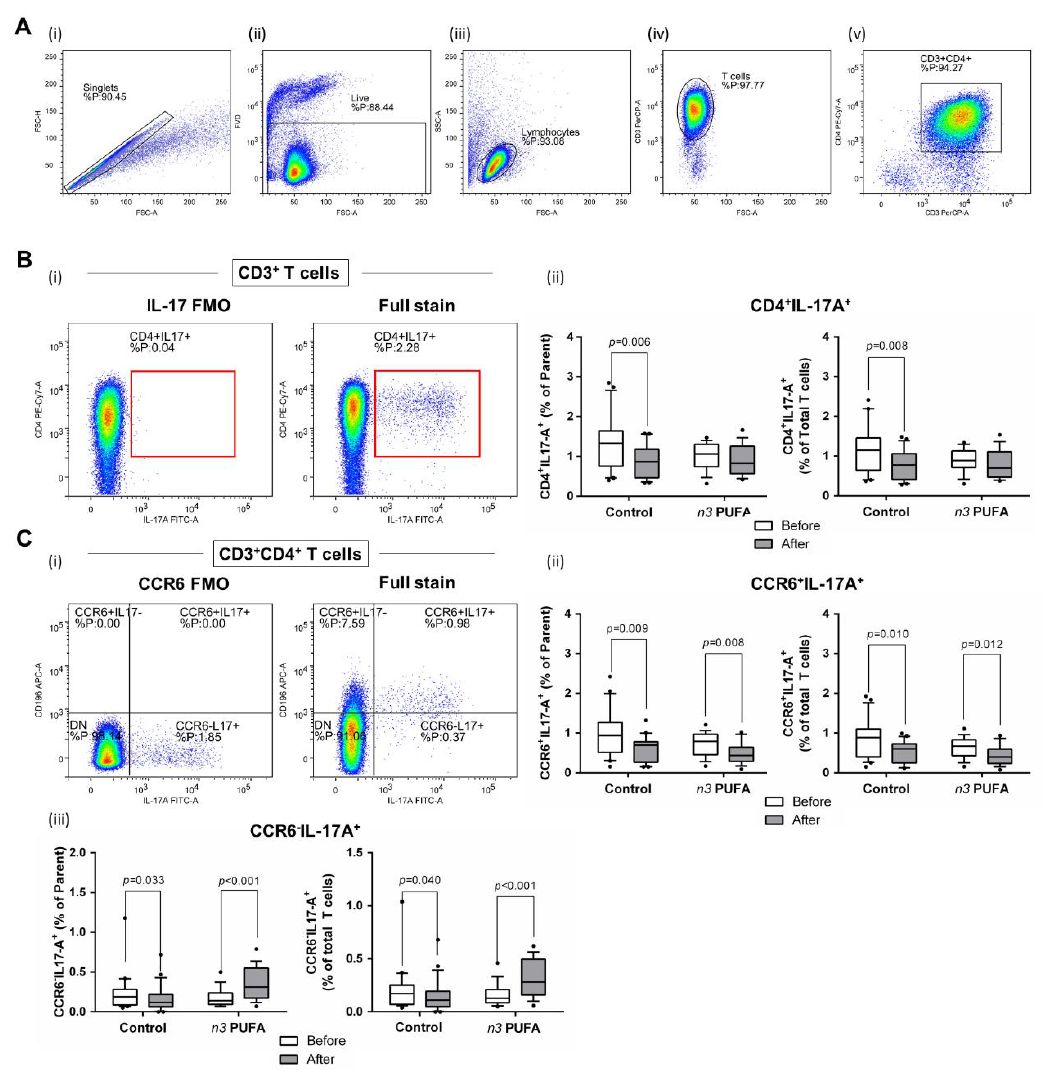
Figure 5. Effects of regular (control group) and n -3 polyunsaturated acid (PUFA)-enriched hen egg ( n -3 PUFAs group) consumption on the representation of peripheral T helper cell subpopulations in healthy young individuals: ( A ) shows representative dot plots illustrating gating strategy, including exclusion of doublets using forward scatter area (FSC-A) versus forward scatter width (FSC-W) analysis (A-i), gating on live cells negative for amine-reactive fixable viability dye (A-ii), lymphocytes (A-iii), CD3 + T cells (A-iv), and CD3 + CD4 + T cells (A-v). T helper cells were subsequently analysed for IL-17A ( B ) and CD196/CCR6 expression ( C ). First; all IL-17 secreting T helper cells were analysed ( B ) where the gate on IL-17 + T cells was defined using fluorescence minus one (FMO) control (B-i) and the relative frequencies of CD4 + IL-17 + T helper cells are presented as box-and-whisker plots at (B-ii). The population of IL-17 secreting T helper cells was further analyse s for CD196/CCR6 expression (C-i), hence two subpopulations were identified—CD4 + CD196 + IL-17 + corresponding to Th17 cells (C-ii) and CD4 + CD196 - IL-17 + non-Th17 cells accounting for other T helper subpopulations with the capacity to secrete IL-17 (C-iii). There was a significant decrease in Th17 cell frequency in both groups following dietary protocol. Frequency of non-Th17 cells was significantly reduced in control group, while the same T cell subpopulation was increased in the n -3 PUFAs group after dietary protocol. Paired t -test, before protocol vs. after protocol; p < 0.05 was considered